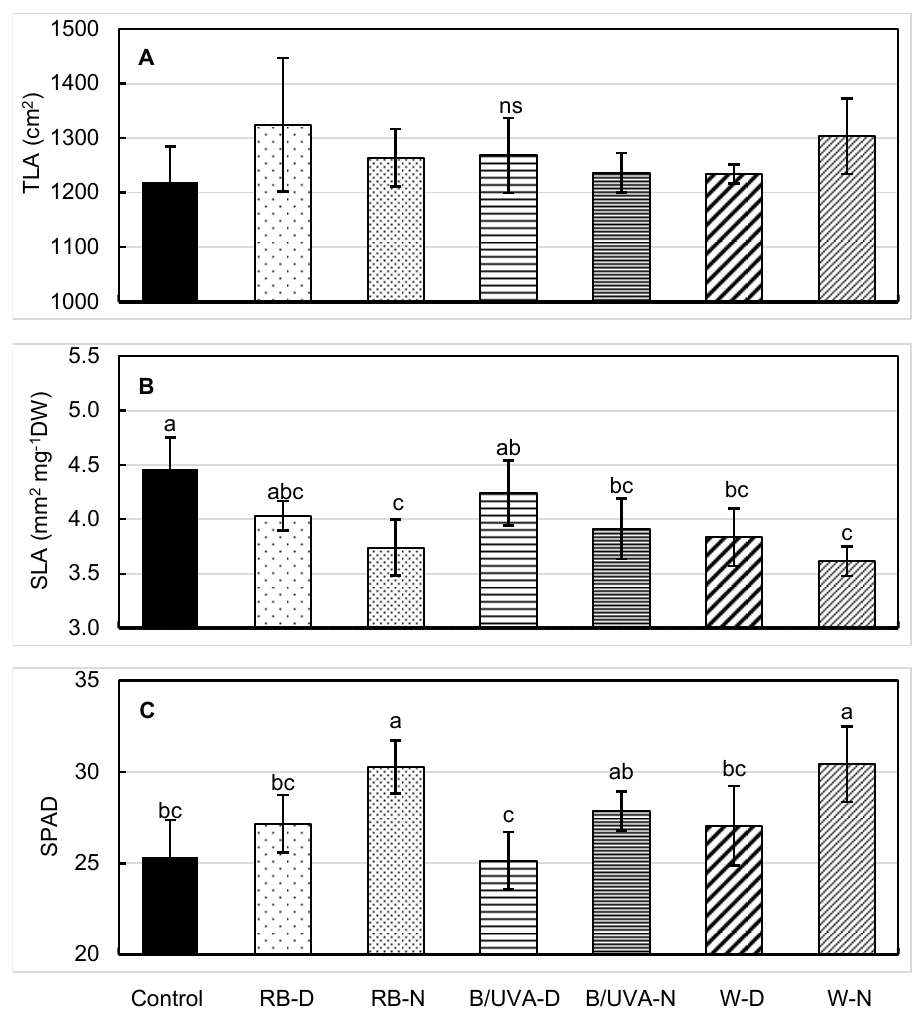
Figure 4. Total leaf area (TLA) ( A ), specific leaf area (SLA) ( B ), and relative chlorophyll content (SPAD) ( C ) of hydroponic lettuce treated with pre-harvest supplemental lighting. Different letters indicate significant differences and “ns” indicate no significant differences according to Tukey’s HSD test ( p < 0.05).